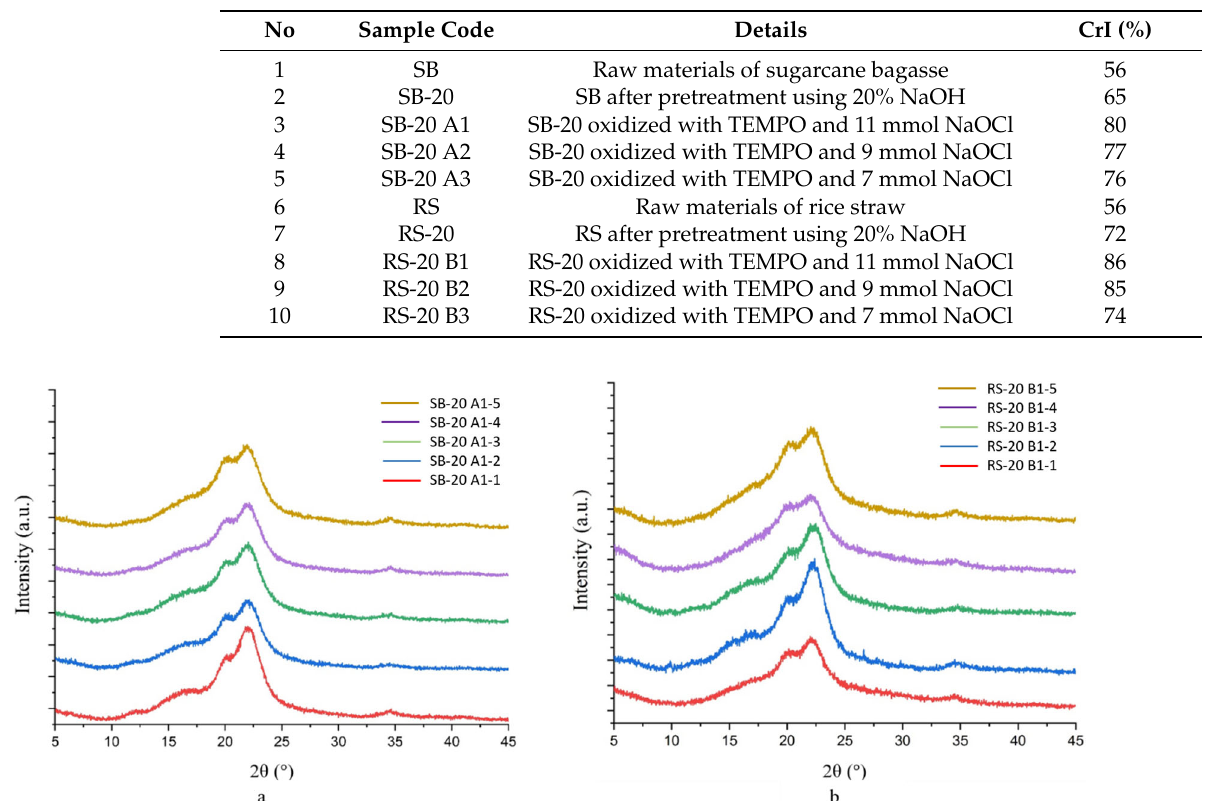
Figure 3. X-ray diffraction patterns of the biomass, the alkaline pretreated biomass, and the CNC from ( a ) sugarcane bagasse (SB), ( b ) rice straw (RS). The number “20” in the sample code indicates that the sample has been pretreated with 20% NaOH. The letters A and B refer to samples from sugarcane bagasse and straw, respectively. The last digit in the CNC sample code indicates a different concentration of NaOCl. 1 = 11 mM NaOCl; 2 = 9 mM NaOCl; and 3 = 7 mM NaOCl. Table 1. Crystallinity of CNC from sugarcane bagasse (SB) and rice straw (RS).